Question: From the figure, is the trend upward or downward?
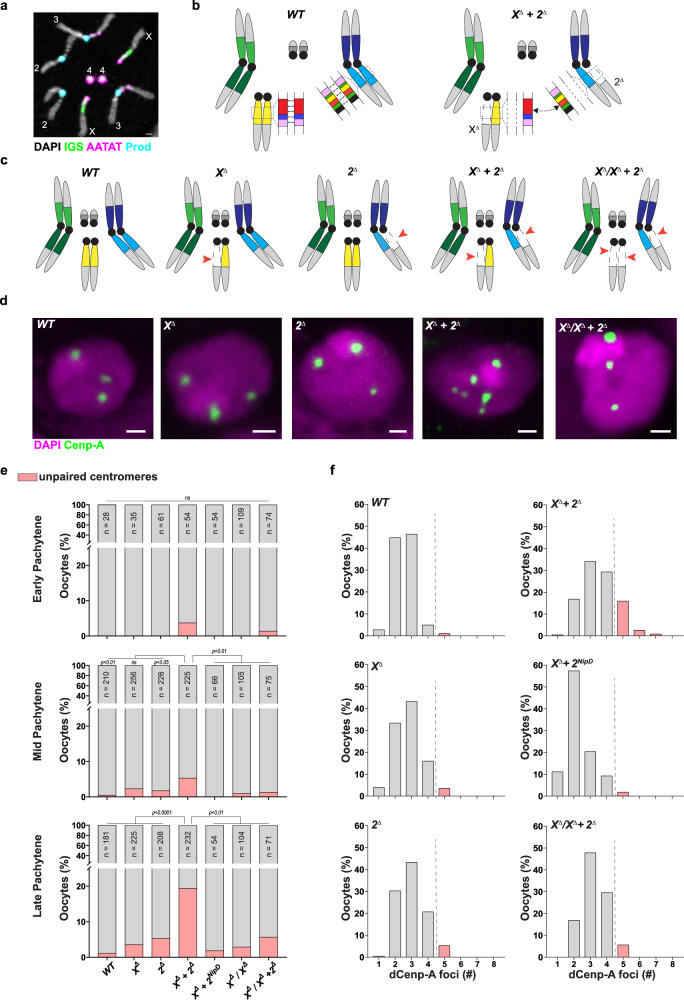
Answer: increasing